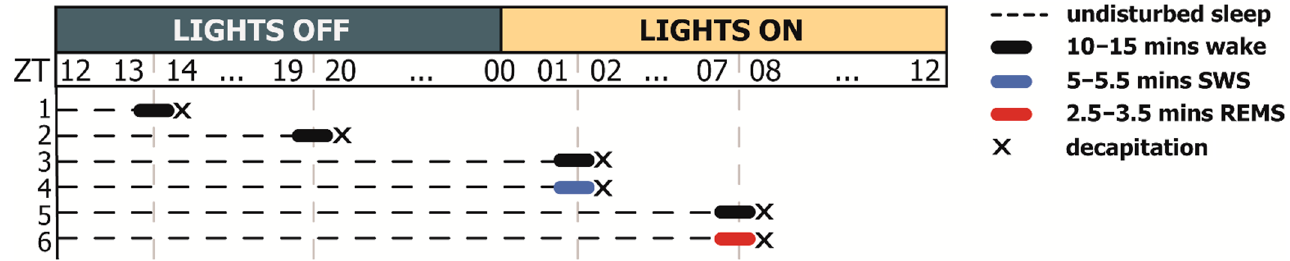
Figure 9. Experiment 1 scheme. To access Hspa1 expression across the daily sleep–wake cycle and compare it with the polysomnographic data, six groups of rats were used ( n = 6 in each group) according to the time of decapitation and the preceding vigilance state, where zeitgeber time (ZT) 00-12 is the lights-on period: (1) ZT13-14, wake; (2) ZT19-20, wake; (3) ZT01-02, wake; (4) ZT01-02, SWS; (5) ZT07-08, wake; (6) ZT07-08, REMS. Following real-time sleep recording, non-anaesthetized rats were immediately sacrificed after 10 min of wake, or 5–5.5 min of SWS, or 2.5–3.5 min of REMS.